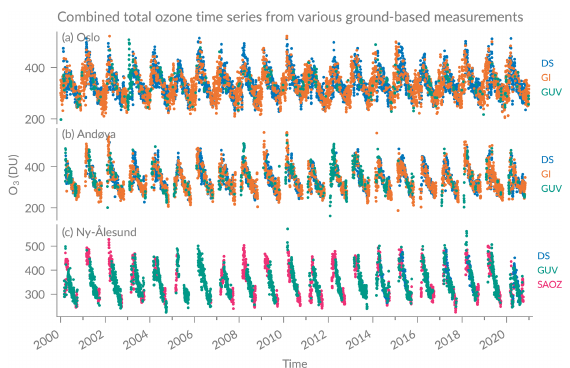
Figure 2. Daily means of total ozone from four different measure- ment techniques: Brewer direct sun (DS), Brewer global irradiance (GI), ground-based UV (GUV), and SAOZ, measured at (a) Oslo, (b) Andøya, and (c) Ny-Ålesund. DS data are the main dataset in Oslo (a) and Andøya (b) , days without DS measurements are filled with GI data, remaining missing data are then filled with GUV mea- surements. In Ny-Ålesund (c) , SAOZ is the main dataset, and DS and GUV are used to fill days with missing SAOZ